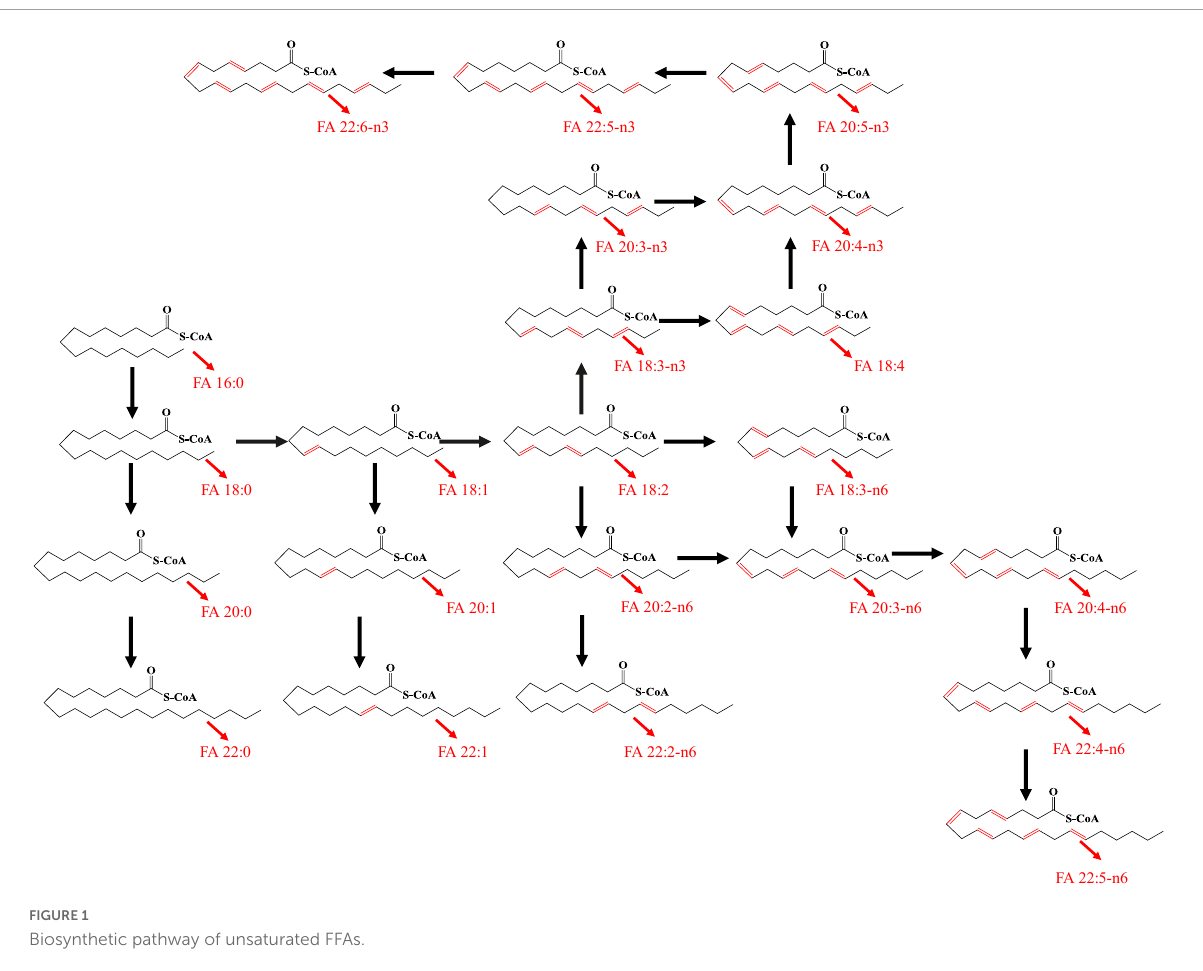
FIGURE1 Biosynthetic pathway of unsaturated FFAs.